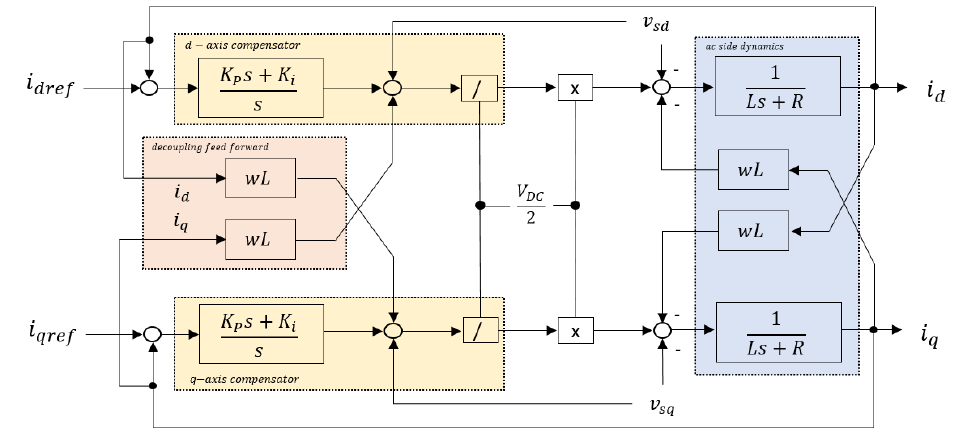
Figure 2. Inner current control